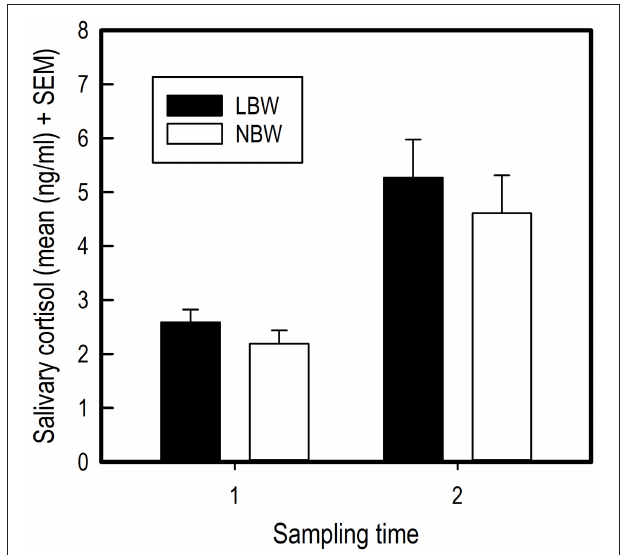
FIGURE 4 | Average salivary cortisol concentrations of LBW and NBW pigs before and after a stressor. There was no significant effect of sex on cortisol concentrations, either as a main effect or interaction with birth weight. Therefore, the data for males and females have been